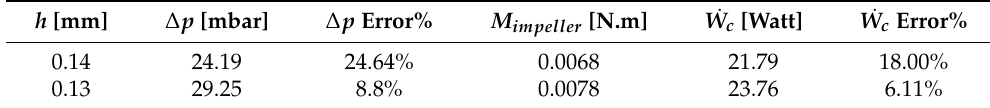
Table 8. Inlet height calibration for the ORP numerical model @ 29,090 RPM.